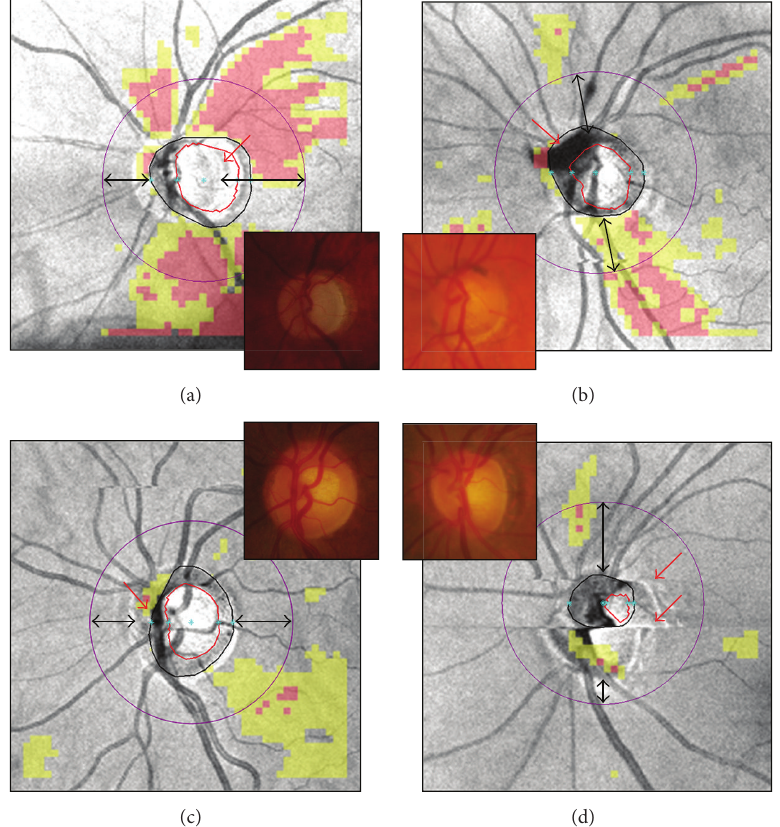
Figure 9: Cirrus HD-OCT inaccurate optic disc margin delineation from peripapillary atrophy, floater, blood vessels’ pattern, and motion artifacts ((a)–(d), red arrows). Color optic disc photographs are shown in the insets for comparison. Along with unreliable optic disc parameters (not shown), note the scan circle displacement in all cases ((a)–(d), double